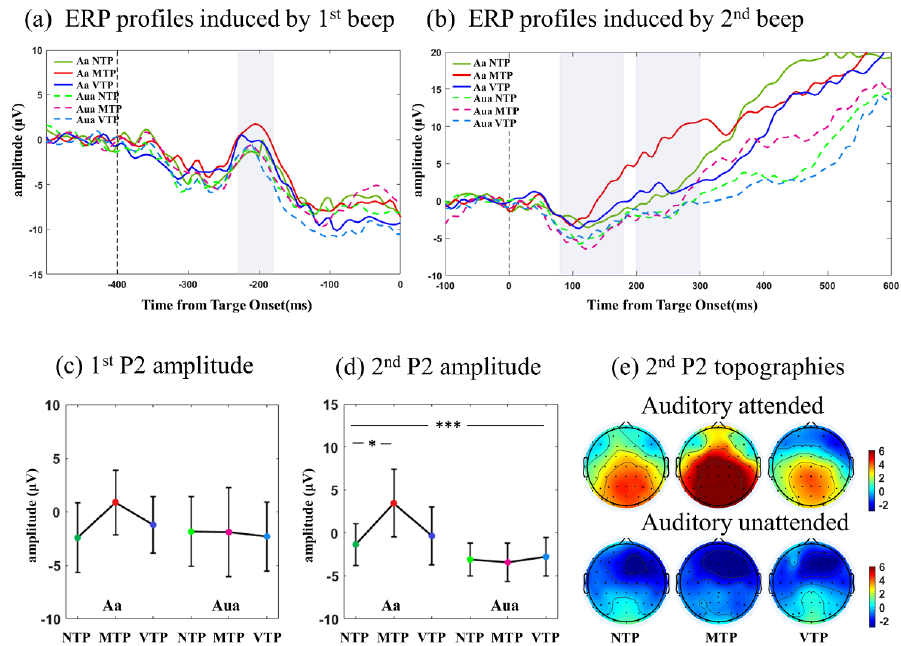
Figure 4. ( a ) Averaged ERPs of F1, FZ, F2 induced by the first beep. ( b ) Averaged ERPs induced by the second beep. ( c , d ) Comparisons of P2 amplitude induced by second beep. ( e ) Amplitude Topographies of P2 induced by second beep. Statistical significance: the asterisks at the top of each figure indicated the MA main effect; the asterisks above the Va condition (Va − NTP, Va − MTP, Va − NTP) indicated the PT simple effect under attended condition, when the MA − PT interactive effect existed. Statistical significance: * 0.01 < p < 0.05; *** p <